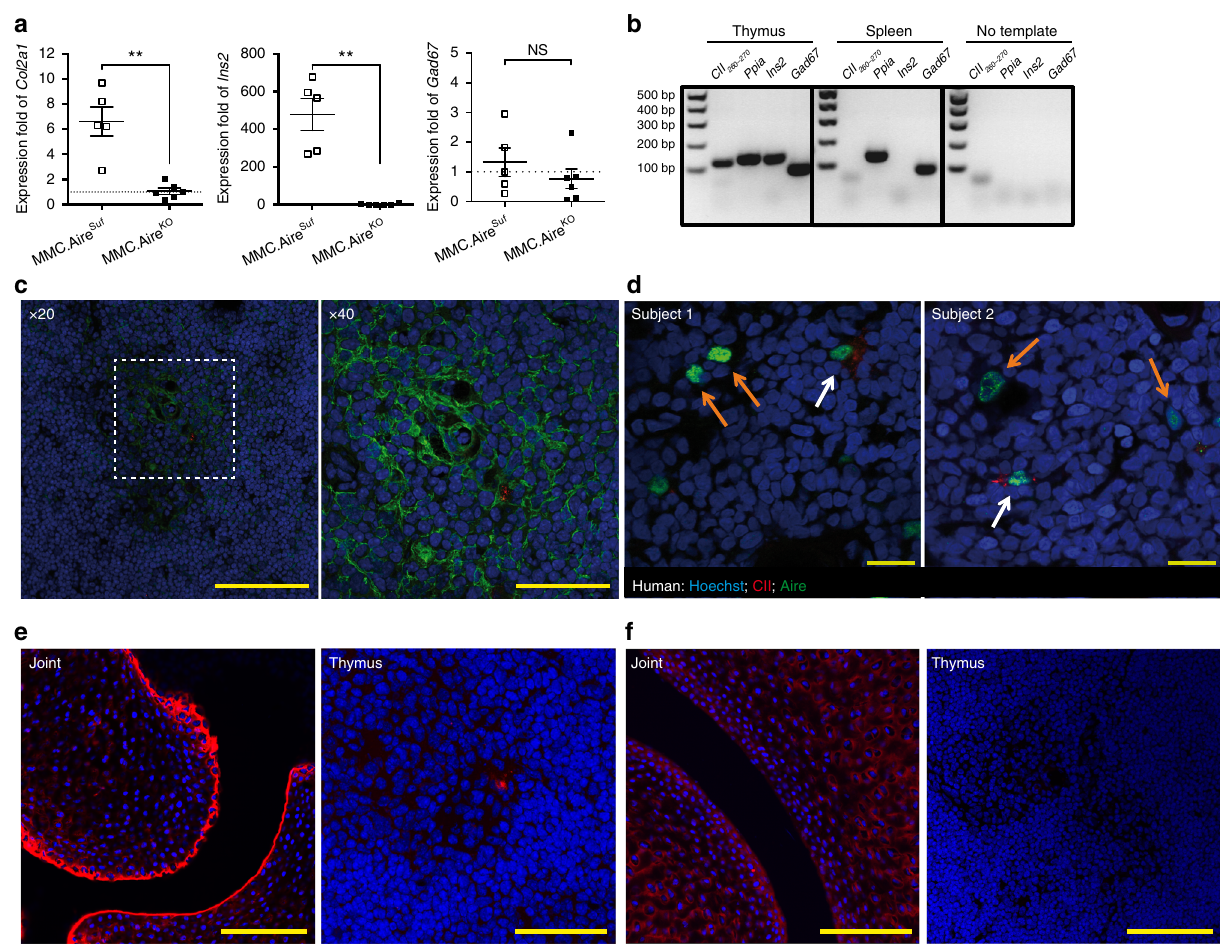
Fig. 3 The CII epitope is expressed in thymic stromal cells of mice and humans. a cDNA derived from thymi of MMC.Aire Suf ( n = 5) and MMC.Aire KO ( n = 6) was prepared and expression of CII ( Col2a1 ) was determined by quantitative RT-PCR. Aire-dependent ( Ins2 ) and Aire-independent ( Gad67 ) genes were used as controls. Data were normalized to the expression of cyclophilin A ( Ppia ) and calibrated with one MMC.Aire KO sample. Mean ± SEM is shown. b Qualitative expression analysis of the immunodominant T cell epitope CII 260 – 270 by RT-PCR on cDNA prepared from whole thymi of 3-week-old mice. As negative control, cDNA was prepared from spleen cells of wild-type mice. Ins2 and Gad67 were used as controls for genes expressed either in the thymus alone or in both thymus and spleen, respectively. Ppia was used as housekeeping gene, whereas no template samples were used as negative controls. c MMC thymus stained for DNA (Hoechst, in blue), keratin 5 (in green), and CII (mAb cocktail, in red). Scale bar in left panel, 100 μ m; in right panel, 50 μ m. d Human thymus sections from two different subjects stained with Hoechst (in blue), anti-AIRE (in green), and anti-CII (in red). Orange arrows indicate thymic epithelial cells positive for AIRE alone. White arrows indicate thymic epithelial cell positive for both AIRE and CII. Scale bar indicates 20 μ m. ( e ) Stain of joint and thymus with Hoechst (blue) and anti-CII (mAb cocktail, red) or ( f ) Hoechst (blue) and anti-PTM CII (T8 mAb, red), from an MMC mouse. Scale bars indicate 100 μ m for left panel of e and both panels of f , and 50 μ m in right panel of e . p values were calculated using Mann – Whitney U test. ** p < 0.01; NS not signi fi